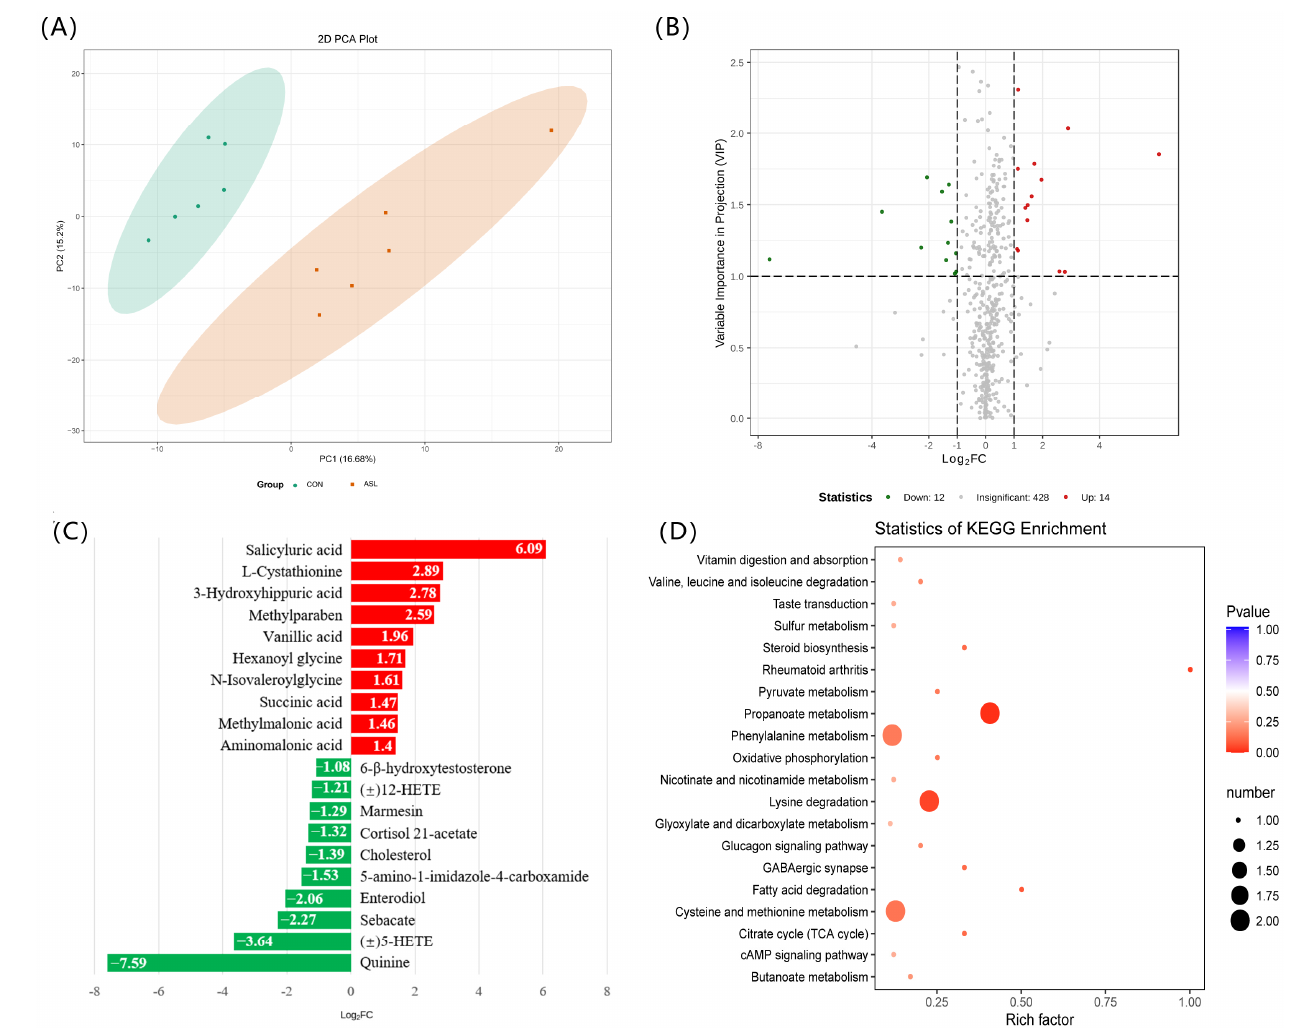
Figure 4. Muscle metabolomics analysis reveals changes in the metabolites and the signal pathways during feeding A. sinensis leaves to goats. ( A ) PCA scores a plot of muscle metabolome distribution according to the diet of goats. ( B ) A volcano plot showing differential muscle metabolites between CON and ASL groups. ( C ) Top 20 differential muscle metabolites between the CON and ASL groups. ( D ) The KEGG enrichment analysis suggests significant changes occurred in the signal pathways of phenylalanine metabolism, lysine degradation, and cysteine and methionine metabolism. CON: a normal diet, ASL: a diet containing 20% A. sinensis leaves. Red indicates an increase, while green indicates a decrease. ( ± )12-HETE: ( ± )12-hydroxy-5Z,8Z,10E,14Z-eicosatetraenoic acid, 5-amino-1-imidazole-4-carboxamide: 5-amino-1-[3,4-dihydroxy-5-(hydroxymethyl)oxolan-2-yl]imidazole-4-carboxamide, ( ± )5-HETE: ( ± )5-hydroxy-6E,8Z,11Z,14Z-eicosatetraenoic acid. Table 5. The longissimus muscle metabolites that differ significantly in the goat samples after feed- ing A. sinensis leaves using UPLC-MS/MS analysis.